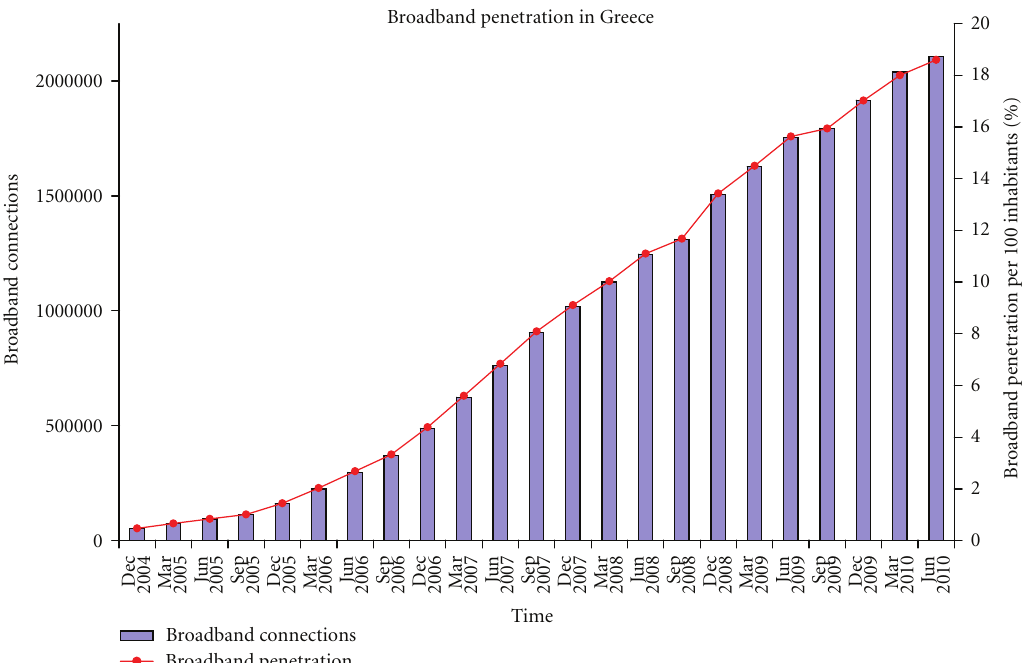
Figure 3: Broadband penetration in Greece (total connections and percentage of the broadband penetration per 100